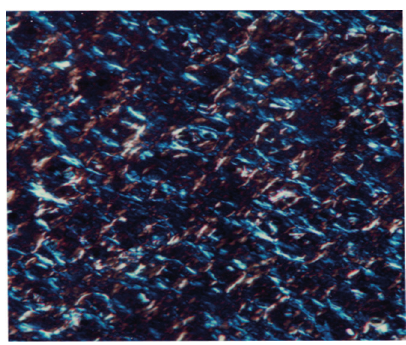
Figure 2. Liquid crystal structure observed under a polarizing